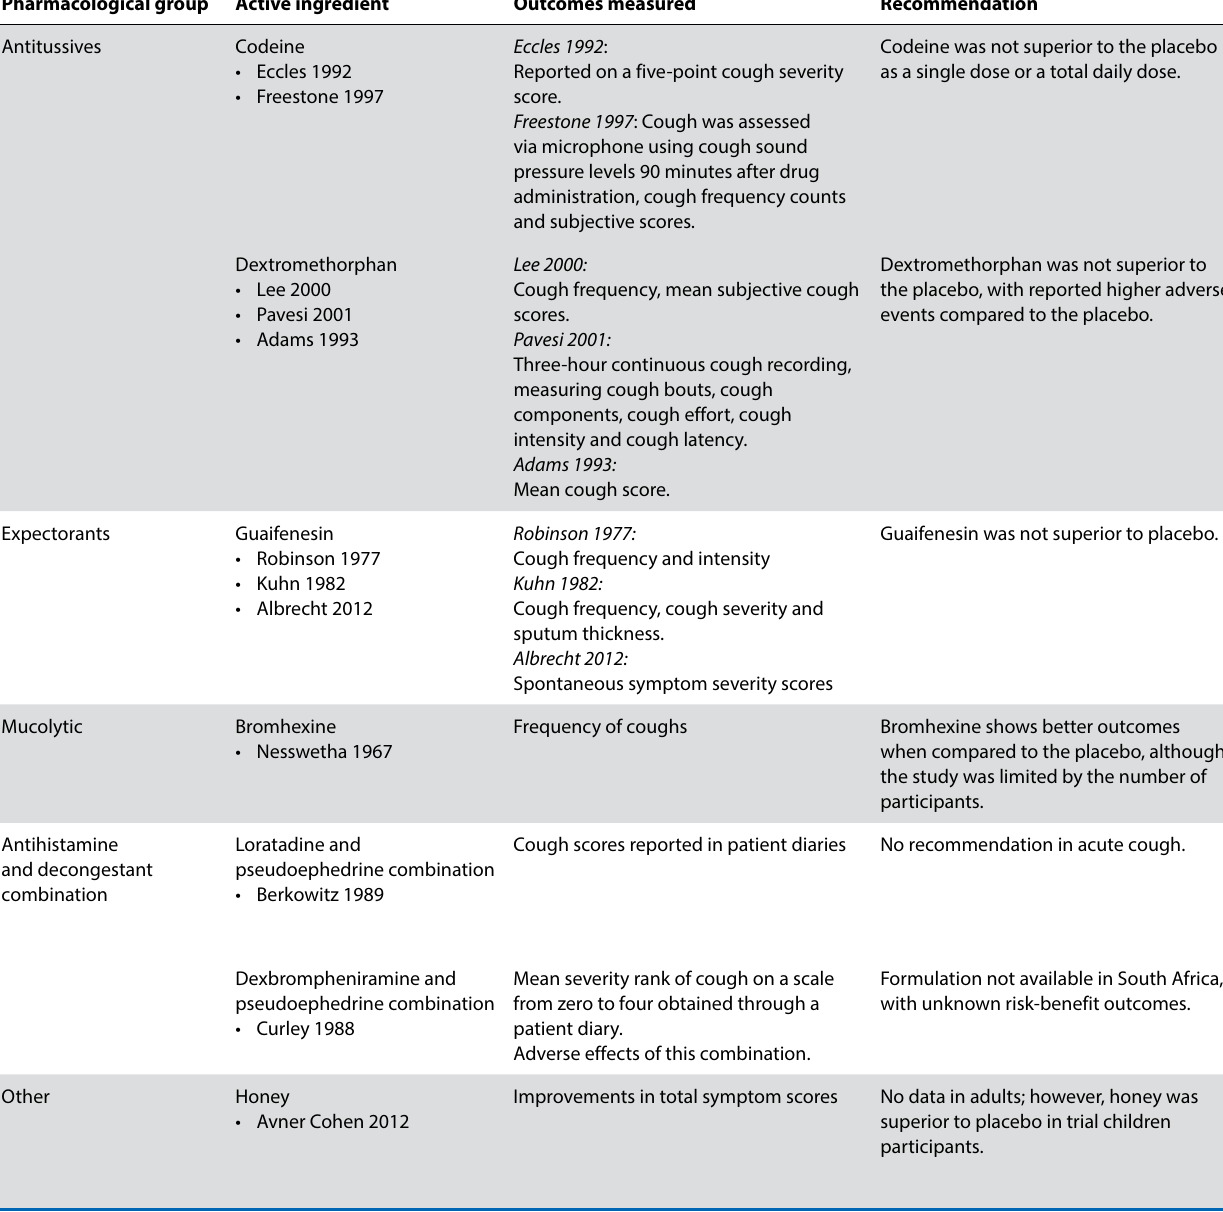
Pharmacological group Active ingredient Outcomes